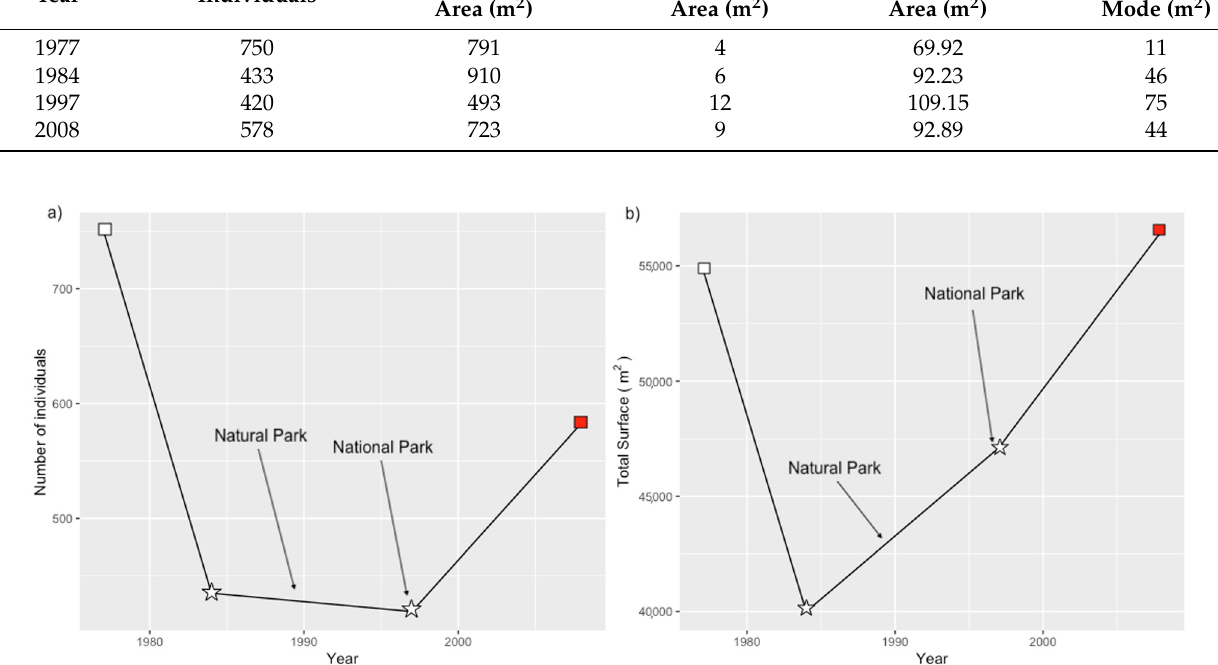
Figure 4. ( a ) Decrease in the number of individuals and ( b ) changes in the shrub canopy area occupied by Juniperus communis L. in Barranco San Juan (Sierra Nevada, Spain) in the period of 1977–2008 following a wildfire that occurred in 1983. The years of the declaration of the Sierra Nevada as a Natural Park in 1989 and as a National Park in 1999 are indicated. The symbols used indicate the spatial and spectral resolution of the images used to estimate the individuals: Square: 0.5 m/pixel. Star: 1 m/pixel. White: panchromatic image. Red: RGB (red-green-blue) image. The number of individuals strongly decreased after the wildfire, continued with a slight decrease from 1984 to 1997, and then recovered by 2008. Canopy cover strongly decreased after the wildfire but recovered at a greater speed.